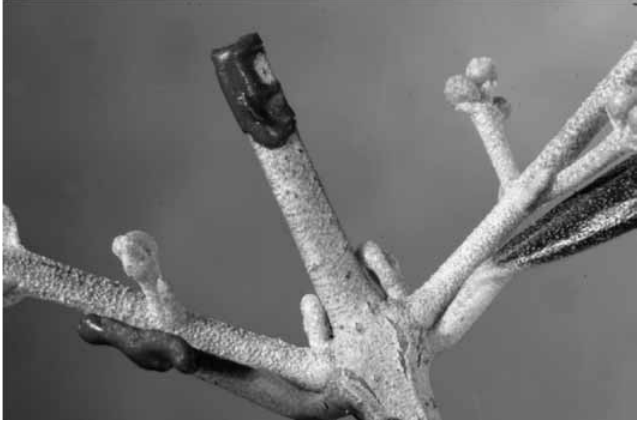
Fig. 3 - Node showing the two main buds producing floral grapes and in upper position the two accessory buds (Photo E.